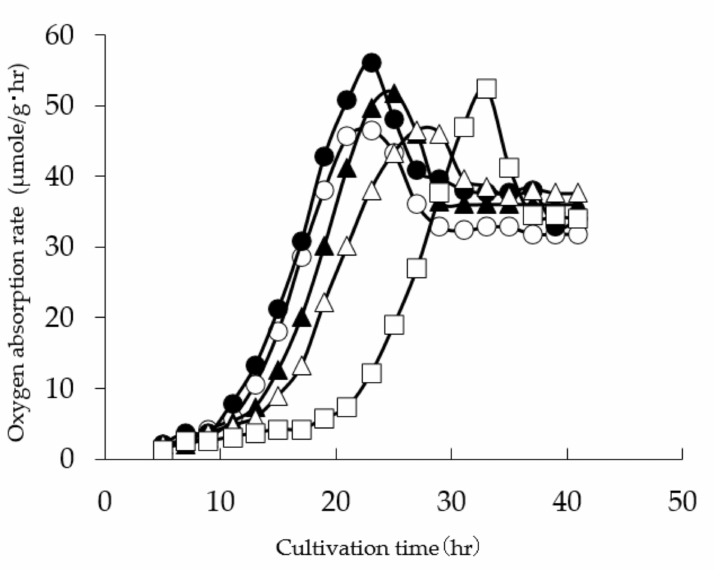
-) Aspergillus (cid:35)